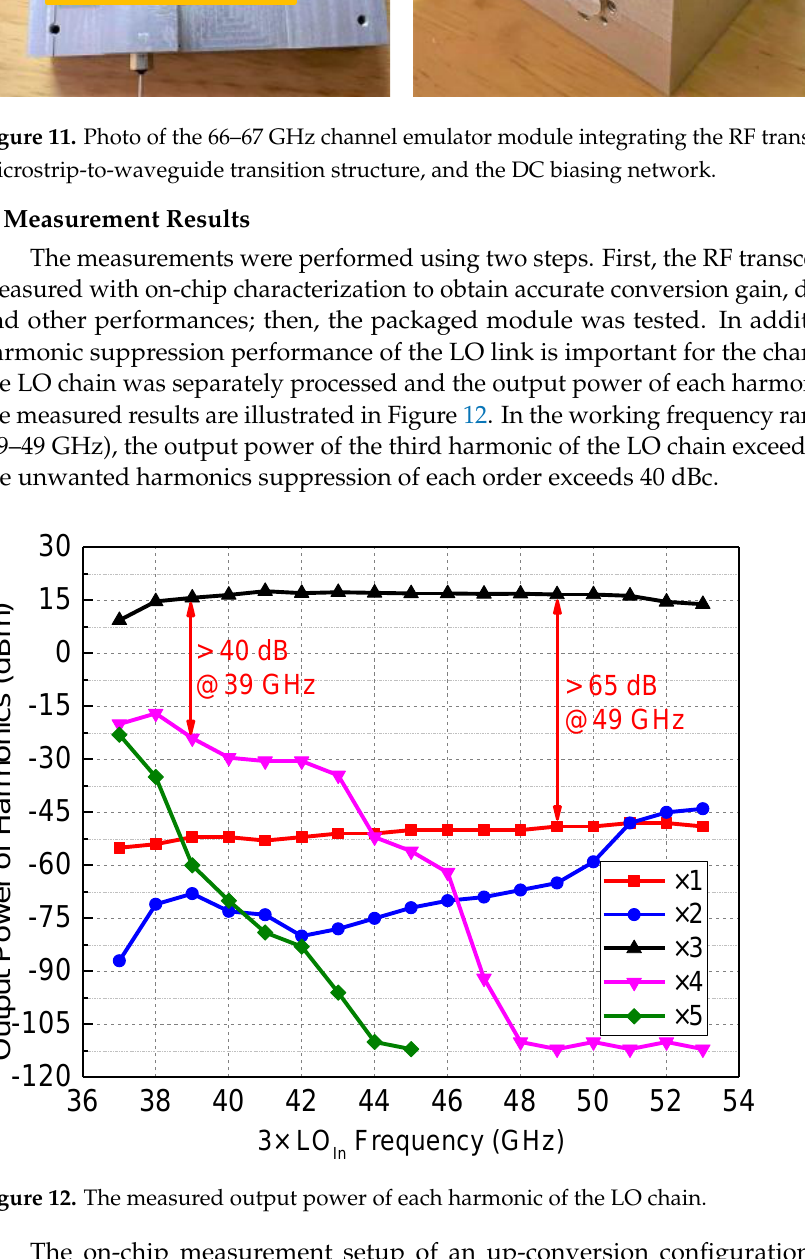
Figure 11. Photo of the 66–67 GHz channel emulator module integrating the RF transceiver chip, the microstrip-to-waveguide transition structure, and the DC biasing network.